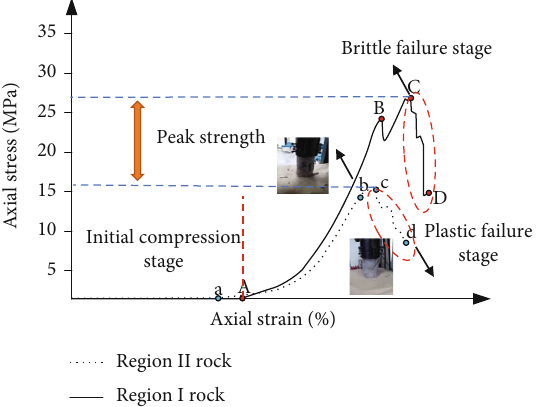
Figure 2: Typical stress-strain curves of mudstone at di ff erent roof